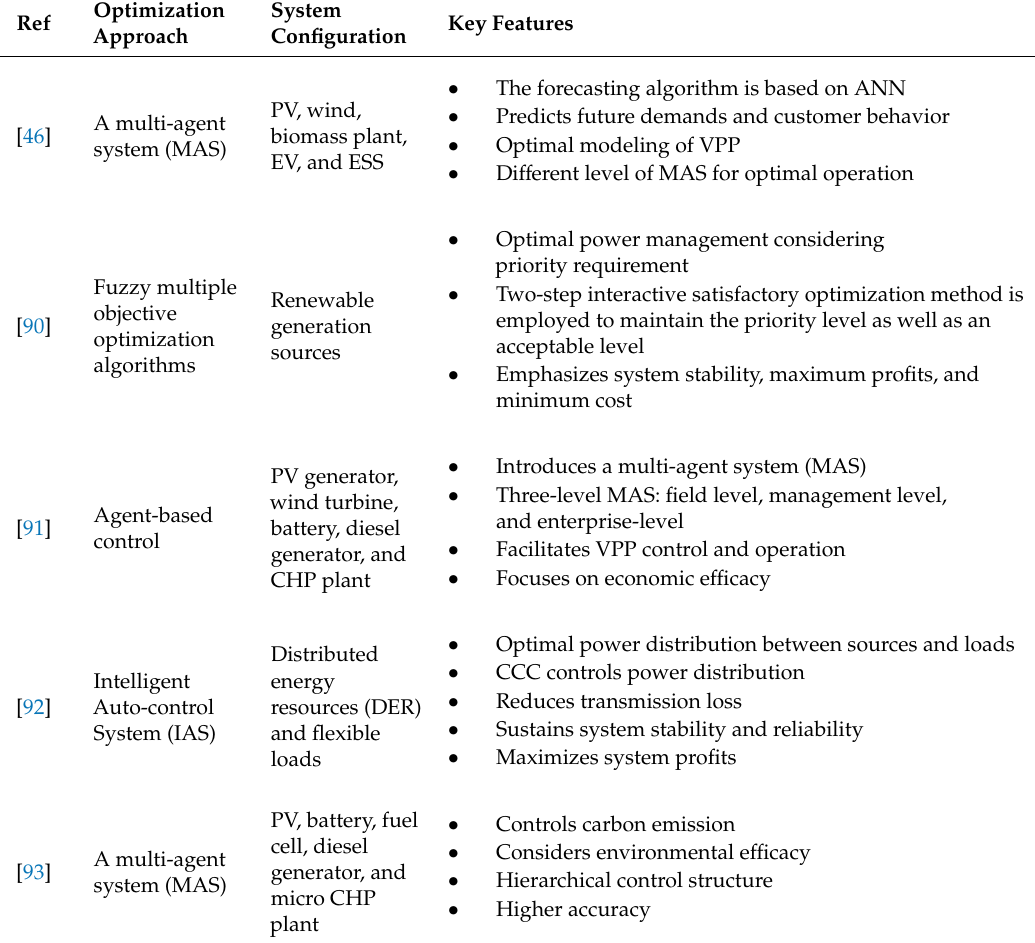
Table 3. An analysis of a virtual power plant optimization algorithm based on the intelligent